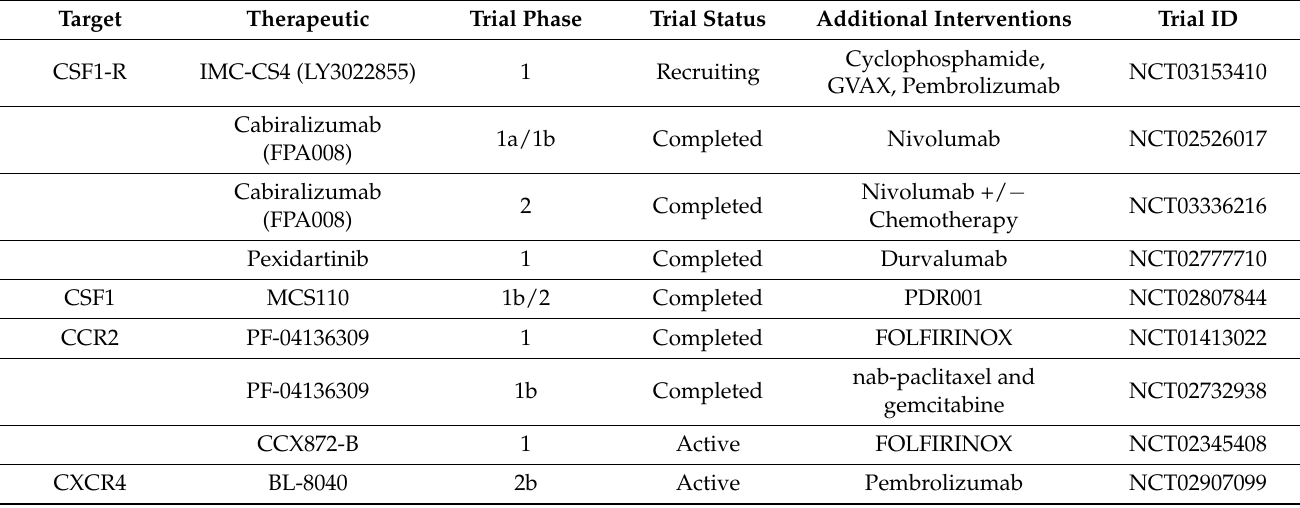
Table 3. Clinical Trials Targeting Tumor-Associated Macrophages in Pancreatic Cancer. Target Therapeutic Trial Phase Trial